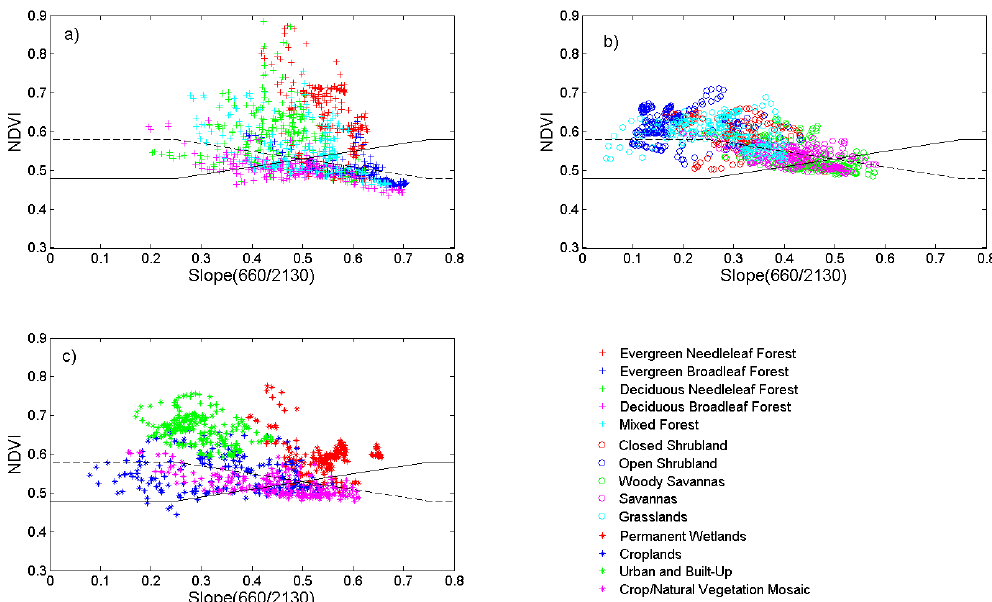
Fig. 6. Dependence of slope NDVI SWIR on NDVI SWIR for different ecotypes based on MODIS surface albedo data. Plot a) presents forest ecotypes (crosses), plot (b) savanna ecotypes (circles) and plot (c) other ecotypes (stars). The solid black line indicates the relationship of the parameters used in the MODIS retrieval (slope NDVI SWIR ) while the dashed line is the inverse version of it. The inverse relationship appears to be a better fit for a number of ecotypes.